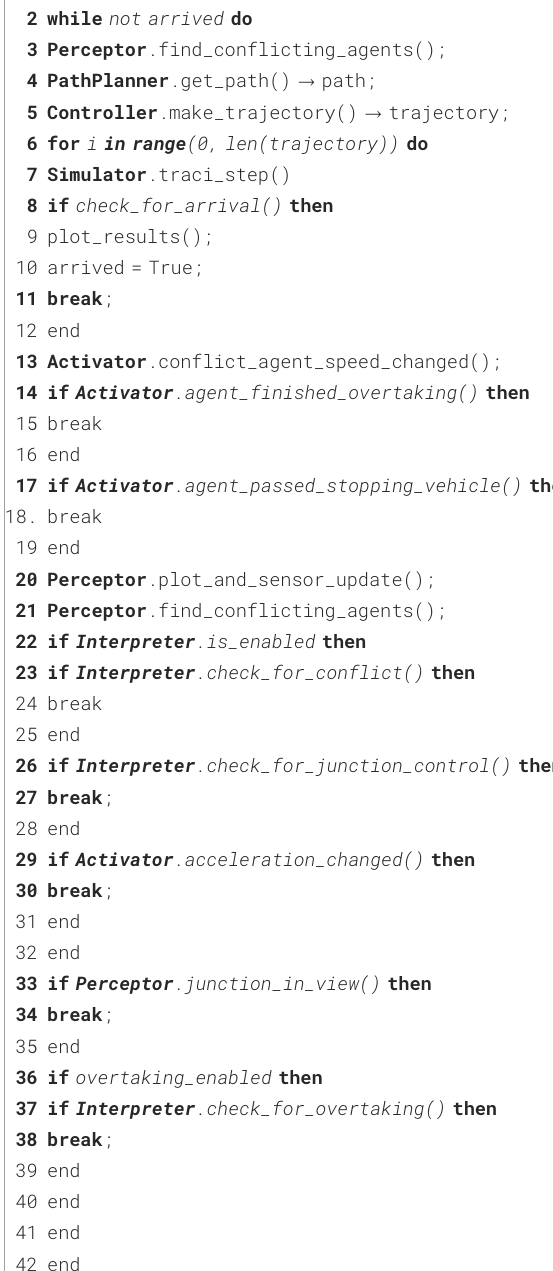
Algorithm 2. The Border Derivation